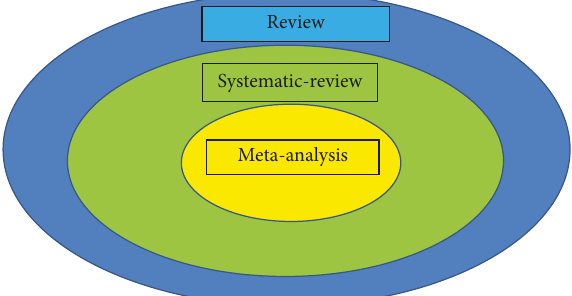
Figure 24: Relationships among meta-analysis, systematic reviews, and review.